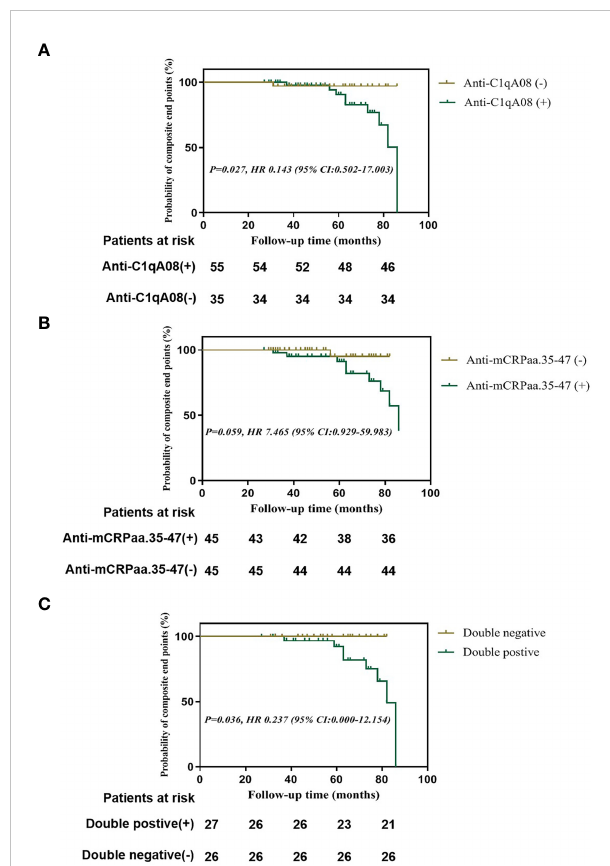
FIGURE 2 Renal outcomes of patients with anti-A08 antibodies and anti-mCRP a.a.35-47 antibodies in LN (A) Comparison of renal outcomes between patients with and without anti-C1qA08 antibodies (B) Comparison of renal outcomes between patients with and without anti-mCRP a.a.35-47 antibodies. (C) Comparison of renal outcomes between patients with double-positive antibodies of anti-mCRP a.a.35-47 antibodies and anti-C1qA08 antibodies and those